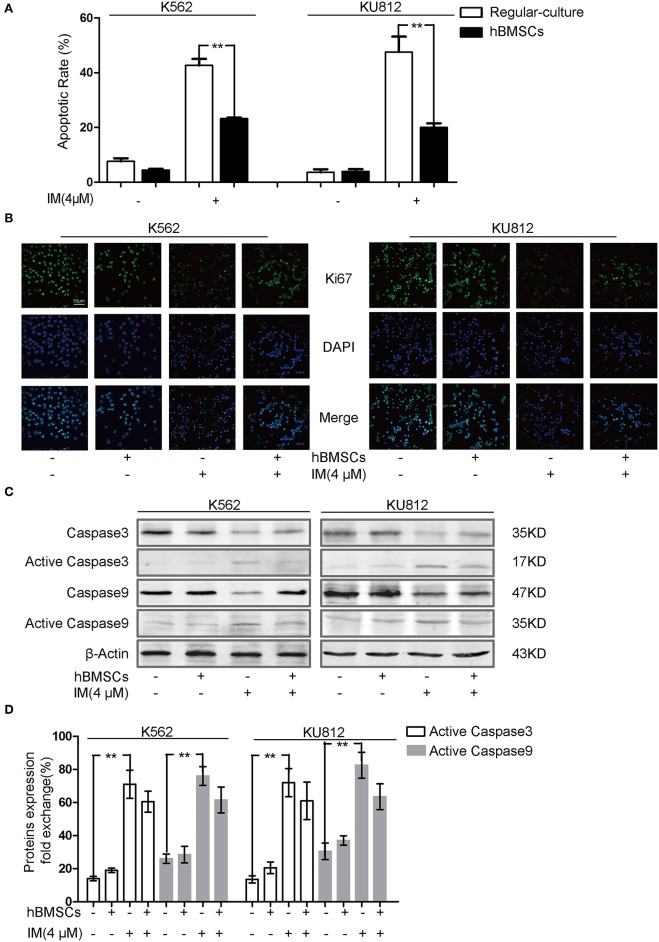
BM microenvironment protected CML cells from IM attack. K562 and KU812 cells were cultured with or without hBMSCs and with or without 4 μM IM for 48 h. Cell proliferation was determined by Annexin V-PI double-staining assay and Ki67 cell proliferation detection. (A) Apoptosis rate of K562 and KU812 after treatment by IM with or without hBMSCs. (B) Ki67 cell proliferation detection of K562 cells after treatment. (C) The expression of cleaved-caspase3 and 9 was determined using western blot analysis. (D) Analysis of proteins expression. Data (A) and (D) were shown as Means ± SD for three independent experiments (*p < 0.05 and **p < 0.01).